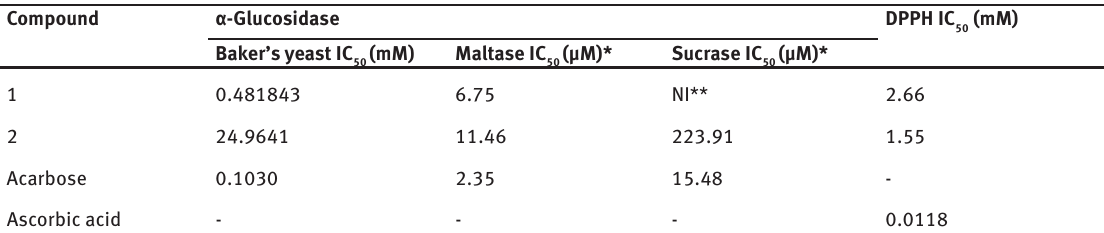
Table 1: α-Glucosidase inhibitory and antioxidant activities of isolated compounds (1-2).